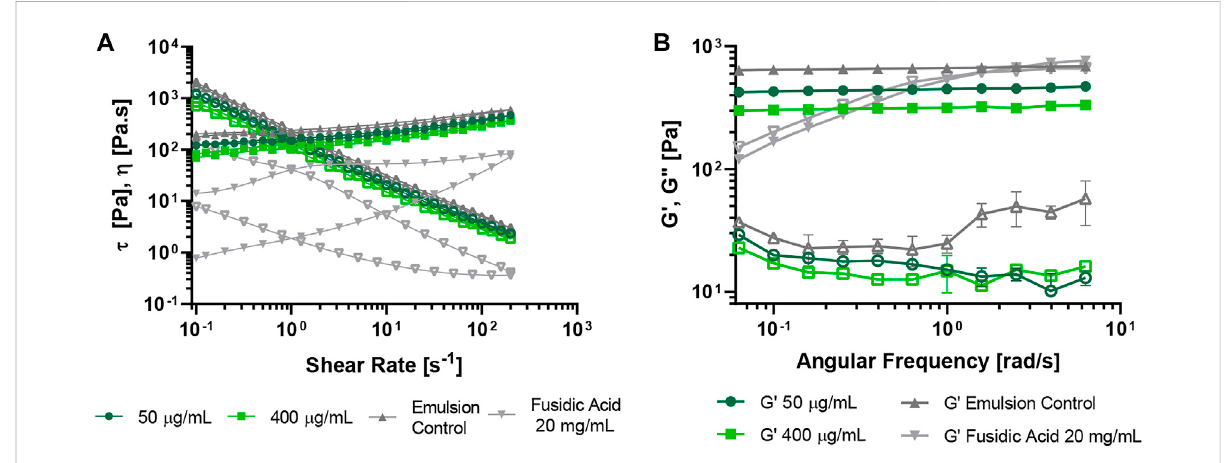
FIGURE 5 Rheological analysis of O/W emulsions performed at 20 ° C. The emulsions were prepared with the MNps-PEG8-BUF-II-Ag nanobioconjugates (50 μ g/mland 400 μ g/ml) at60%wt.and HLB14.Thebareemulsionandacommercial control basedonfusidicacid wereemployed ascontrols. (A) Stress τ vs. shear-rate and viscosity η vs. shear-rate (hollow symbols) at 0.1 – 200 s − 1 . (B) Frequency Sweep analysis of O/W emulsions performed at 20 ° C, 1% strain and 0.01 – 1 Hz (hollow symbols correspond to G ″ ).